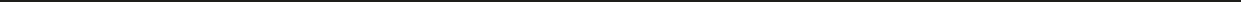
Fig. 5 Adipose-selective expression of H3.3K36M depletes H3K36 methylation and reprograms BAT. a Schematic of transgenic (A-K36M) construct. Expression of FLAG-tagged H3.3K36M is under the control of the 7.9 kb adipose tissue-selective Fabp4 promoter. b Tissue distribution of FLAG-tagged H3.3K36M in A-K36M mice was determined by Western blot. All data in this fi gure were from 8-week-old to 10-week-old male mice fed with regular diet. c Western blot in BAT of control (Ctrl) and A-K36M mice. d Representative picture of Ctrl and A-K36M mice (left). Fat mass, lean mass, and total body weight of Ctrl and A-K36M mice ( n = 6 per group) were measured by MRI (right). e Representative pictures of interscapular WAT (iWAT), BAT, retroperitoneal WAT (rWAT), inguinal WAT (ing-WAT), epididymal WAT (epi-WAT), and liver. f Average tissue weights in Ctrl and A-K36M mice ( n = 6 per group) are presented as % of body weight. g Enlarged images (upper panels) and H&E staining (lower panels) of BAT isolated from Ctrl and A-K36M mice. Scale bar = 100 µ m. h qRT-PCR analysis in BAT of Ctrl and A-K36M mice ( n = 6 per group). i Western blot of PPAR γ , C/EBP α , and Ucp1 in BAT isolated from Ctrl and A-K36M mice. j – l BAT and epi-WAT were collected from A-K36M and Ctrl mice for RNA-Seq. j Heatmaps of BAT-enriched or epi- WAT-enriched genes. Column 1, log fold change between RPKM of BAT vs. epi-WAT in Ctrl mice. Top 1000 WAT-selective or top 1000 BAT-selective genes were analyzed. Columns 2 – 3, log fold change between RPKM of A-K36M vs. Ctrl mice (A-K36M/Ctrl) in BAT (column 2) or epi-WAT (column 3). k , l RPKM values of WAT-selective ( k ) or BAT-selective ( l ) genes. m , n Cold tolerance test. Ctrl and A-K36M mice ( n = 6 per group) were housed at room temperature (22 °C) or in cold (4 °C) for 2 h. m Body temperatures. n qRT-PCR of Ucp1 and Dio2 in BAT. All values in d , f , h and m , n are presented as mean ± SEM. Statistical comparison between groups was performed using Student ’ s t test. * p < 0.05, ** p < 0.01, and *** p <